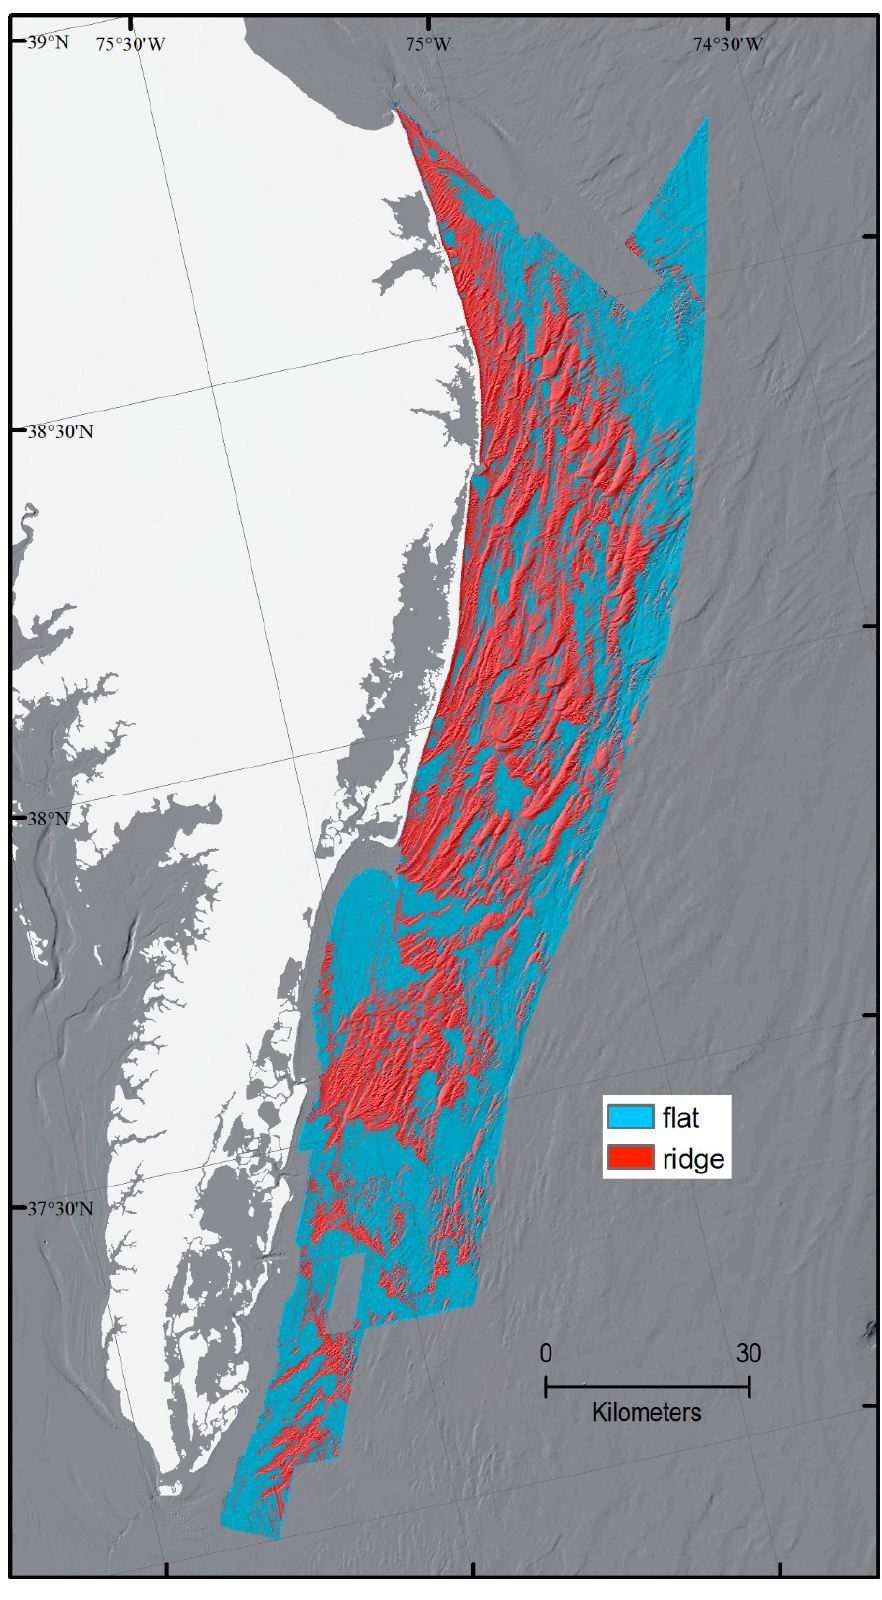
Figure 8. Geomorphologic classes derived from the four classes by combining the low slope (LBLS and HBLS) and steep slope units (LBSS and HBSS).